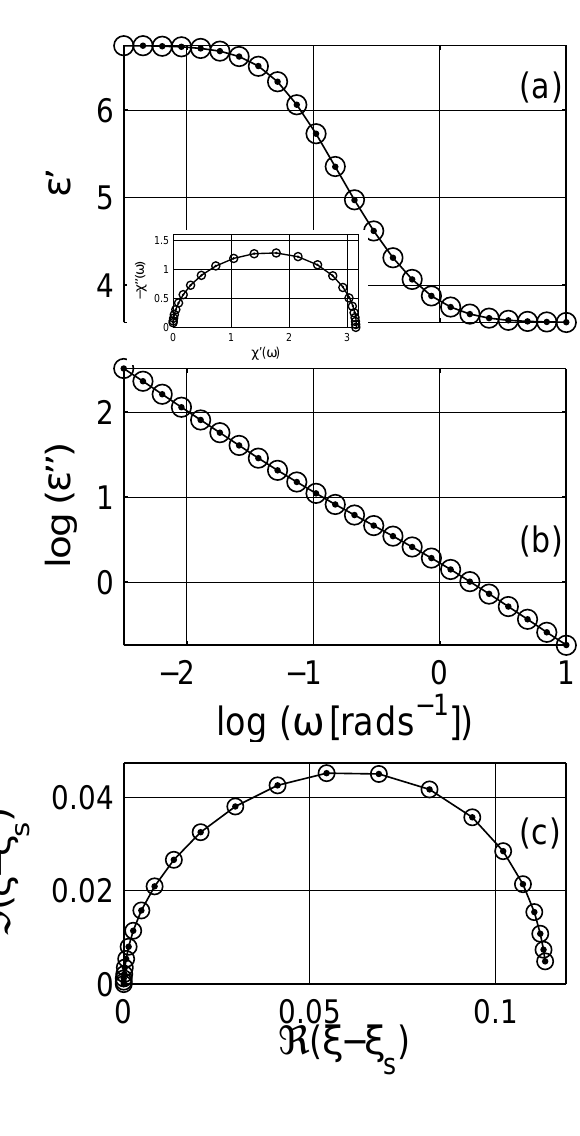
(c) Argand diagram